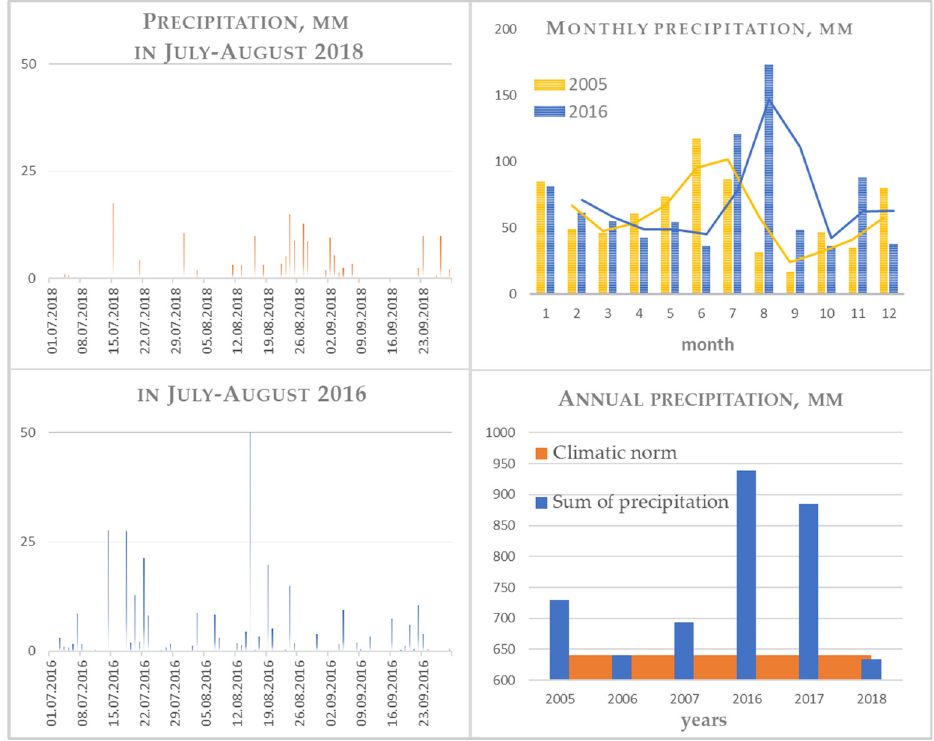
Figure 3. Precipitation for the observation period.